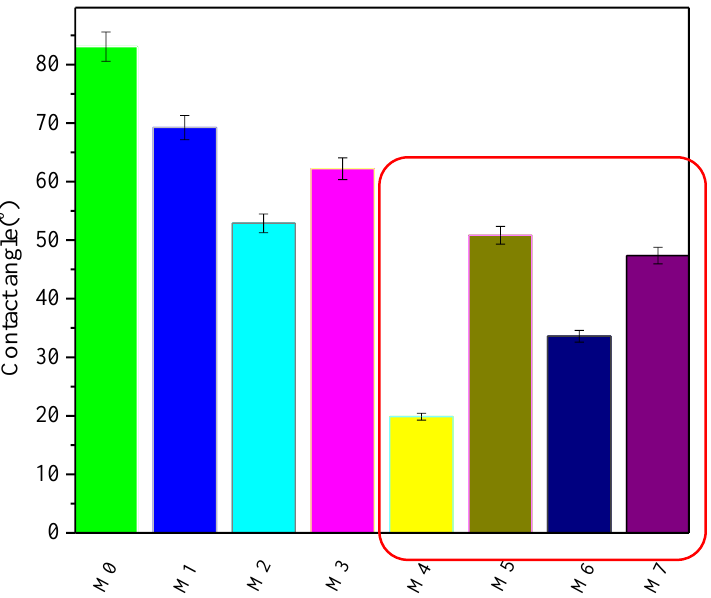
Figure 12. The contact angle of M0, M1, M2, M3, M4, M5, M6, and